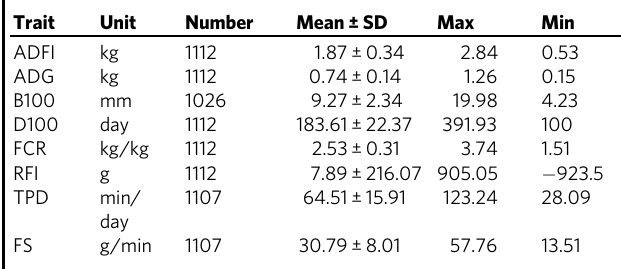
Table 1 Descriptive statistics of phenotypes for eight socially – affected traits in Yorkshire pigs.